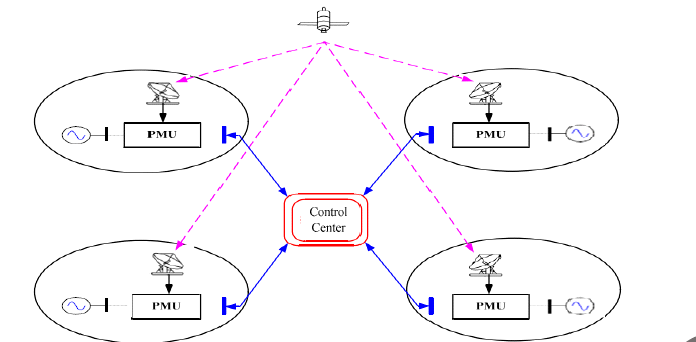
Figure 11. Synchronized PMU detection based on GPS signal.